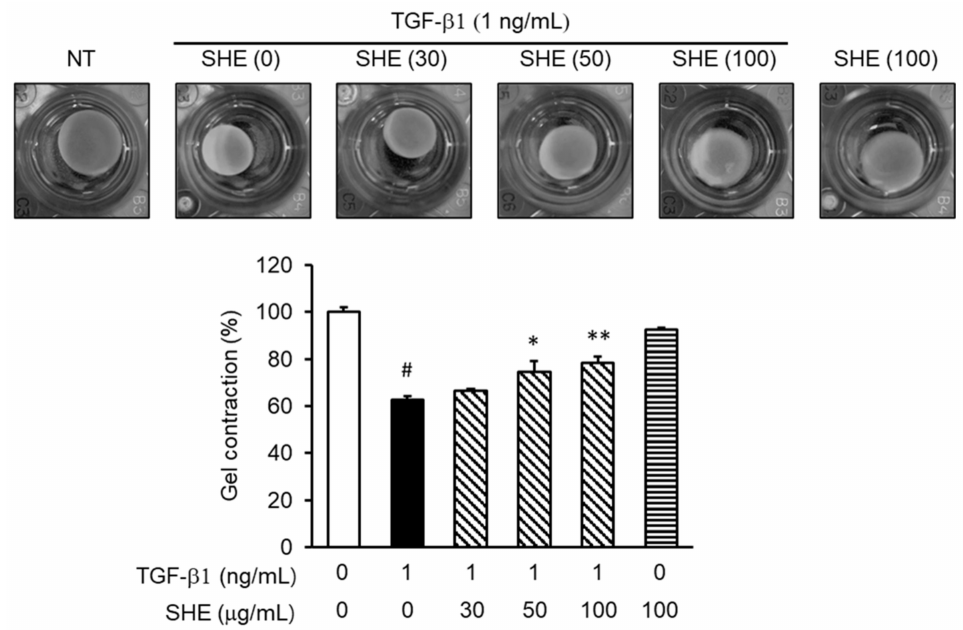
Figure 6. Effect of SHE on the contractile activity of NPDFs in rat tail type I collagen gel. Cells were applied in rat tail type I collagen gels (1 mg/mL) and pretreated with SHE for 1 h. Next, the mixture of collagen gel and the cell was treated with TGF- β 1 (1 ng/mL) and then cultured for another 24 h. TGF- β 1 stimulation decreased the gel size, while SHE pretreatment blocked this reduction in gel size. It was evaluated and quantified as the sum of the percentage of gel surface area in each well relative to the control gel surface area. Each bar represents the mean ± SEM ( n = 3) from three independent experiments. # p < 0.05 vs. control group (no treatment group); * p < 0.05 and ** p < 0.01 vs. TGF- β 1-stimulated group.